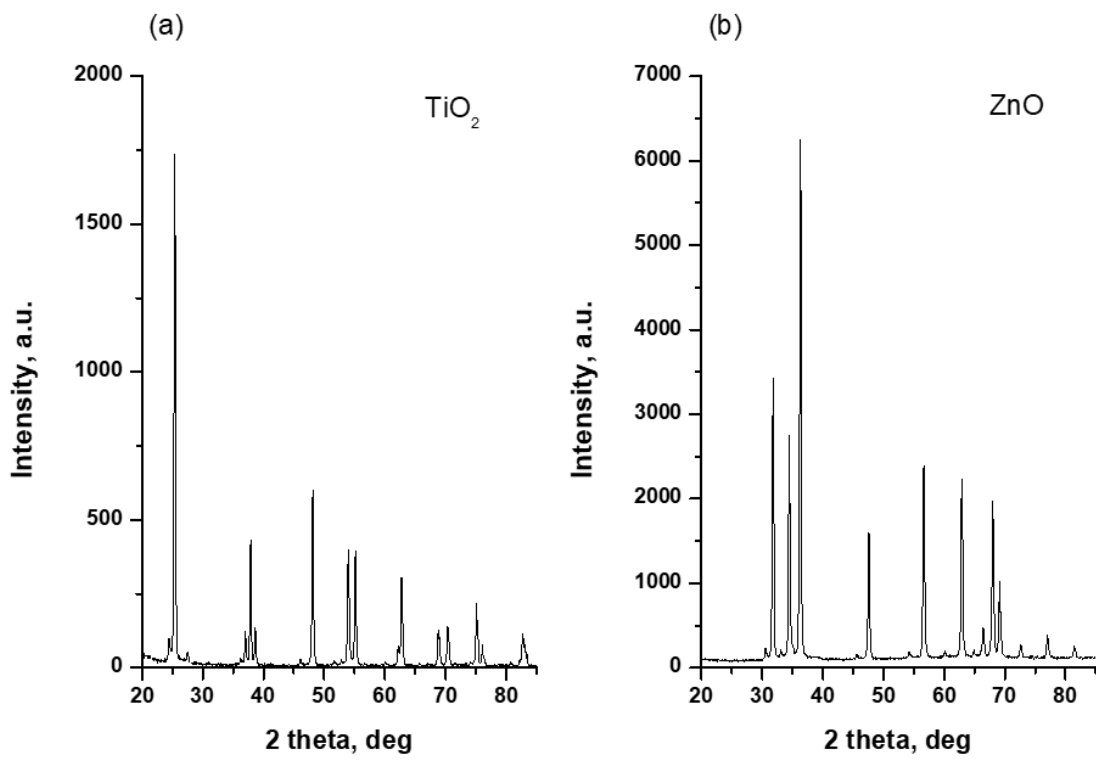
Figure 2. XRD patterns of ( a ) TiO and ( b ) ZnO.